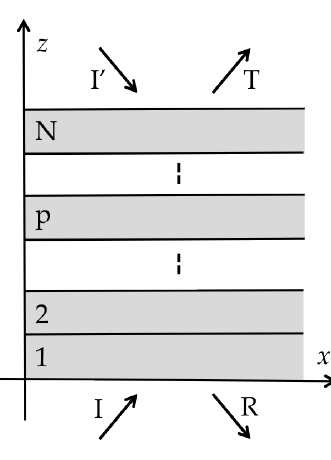
Figure 1: General scheem of a multilayered